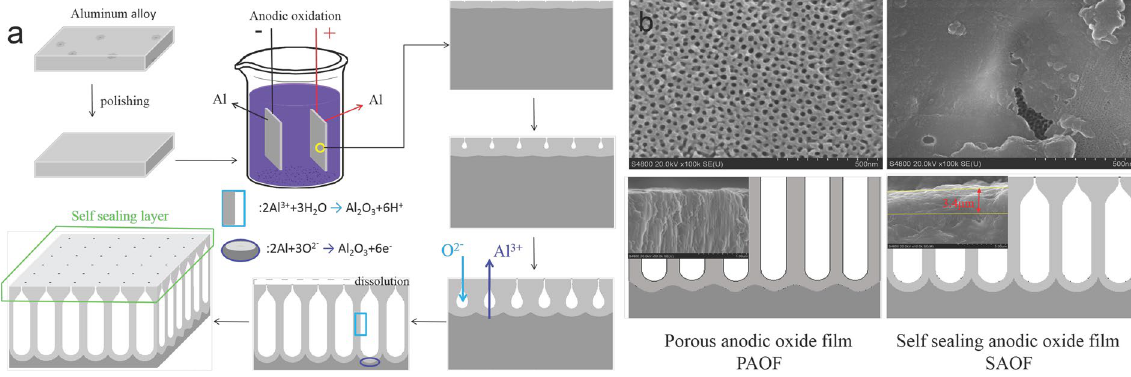
Figure 1. The formation of self-sealing layers on AOF in anodic oxidation and the morphology of PAOF and